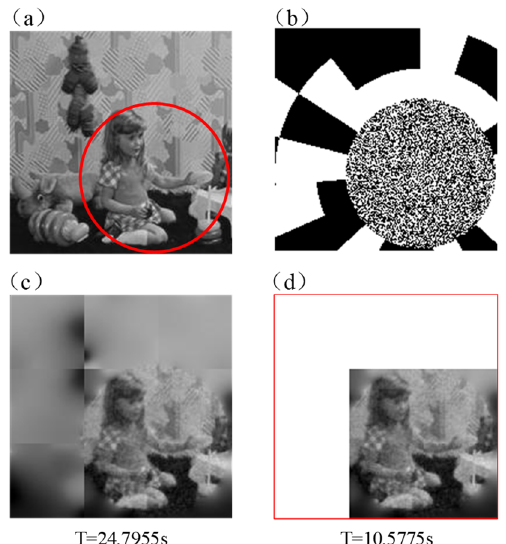
Figure 9. Imaging results of reconstructing the whole image and reconstructing part of the image. ( a ) Original image; ( b ) Sample of retina-like patterns; ( c ) The result of reconstructing the whole image; ( d ) The result of reconstructing part of the image.